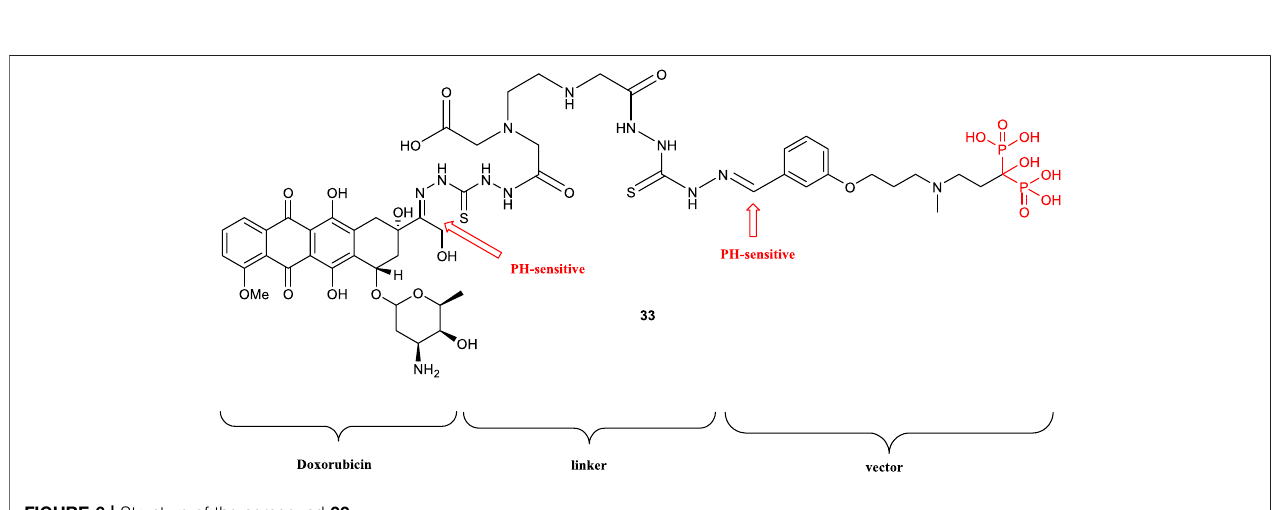
FIGURE 6 | Structure of the compound 33